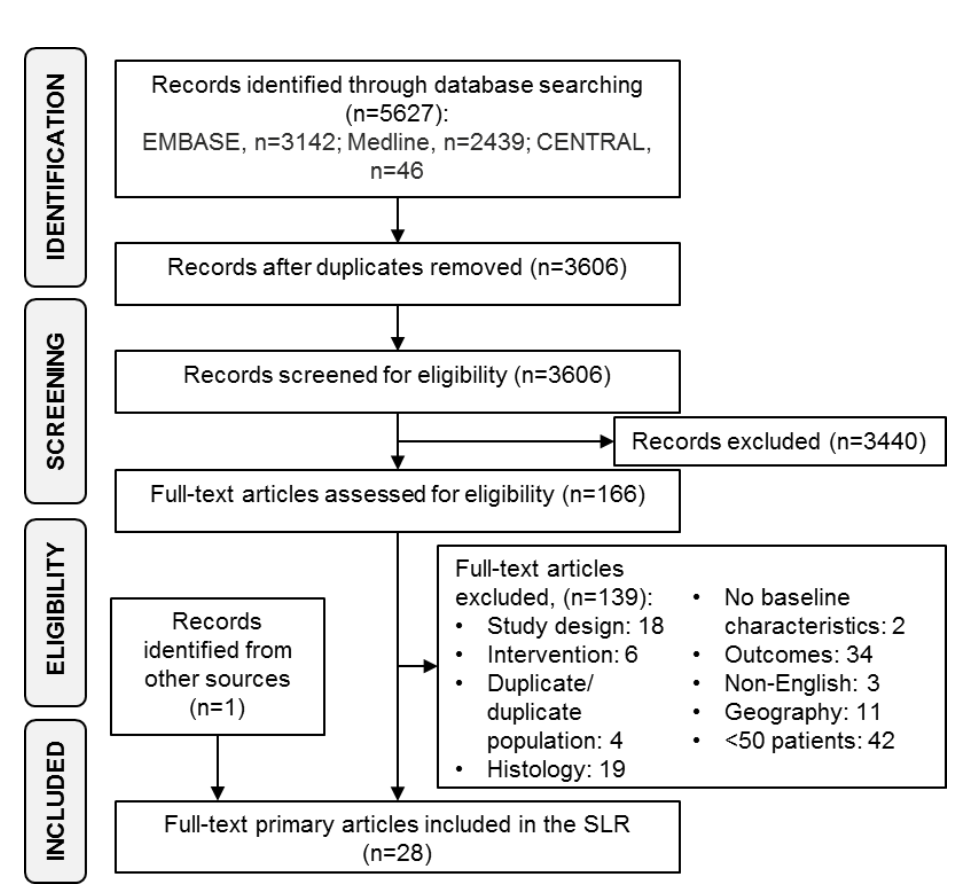
Figure 1. PRISMA diagram.